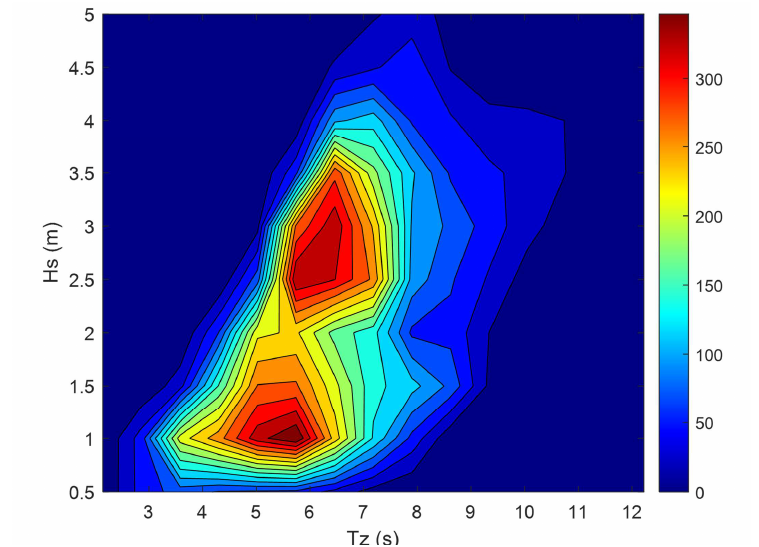
Figure A1. Hours of occurrence of each wave state of Yeu island